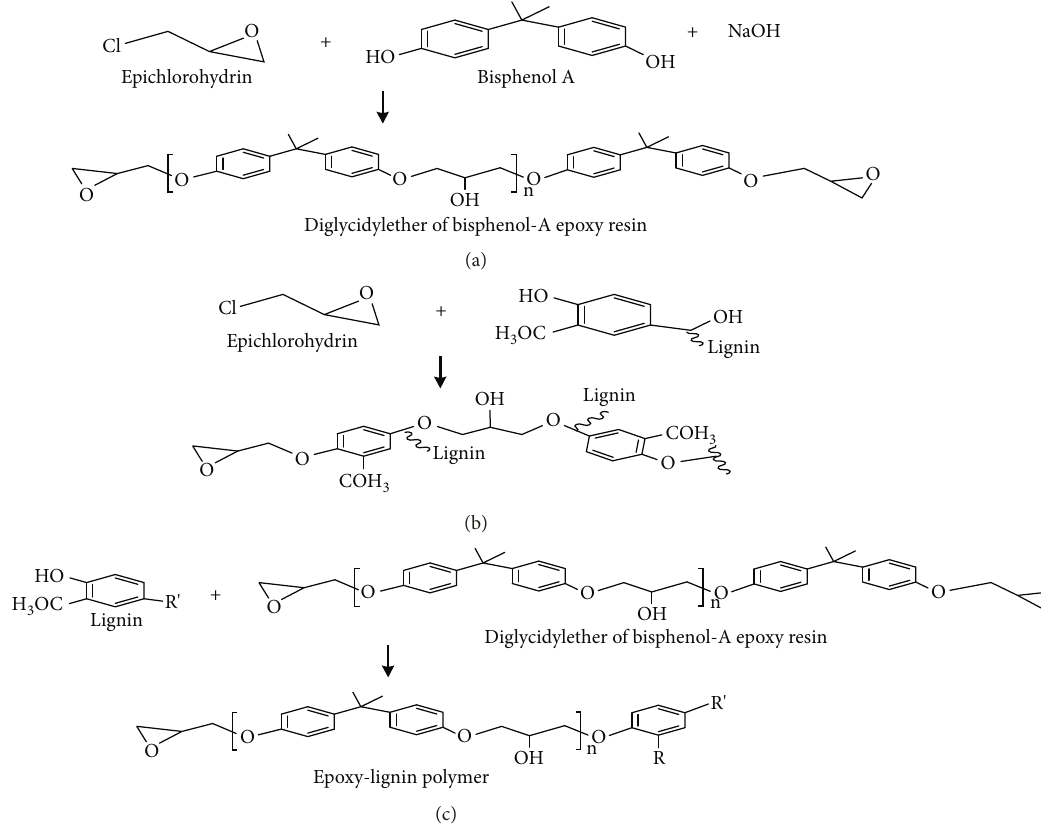
Figure 3: Proposed pathway in synthesis of lignin-bisphenol A epoxy resin: (a) bisphenol A-epoxy resins, (b) cross-linking of lignin with epichlorohydrin, and (c) lignin-bisphenol A epoxy resin [110] (Copyright @ 2017 Springer-Verlag GmbH,